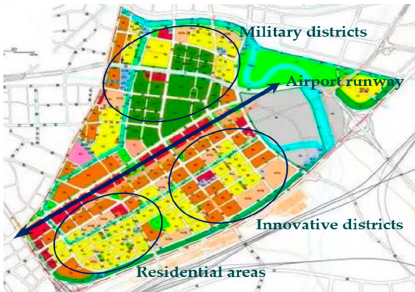
Figure 1. Planning diagram of the Southern New City region.